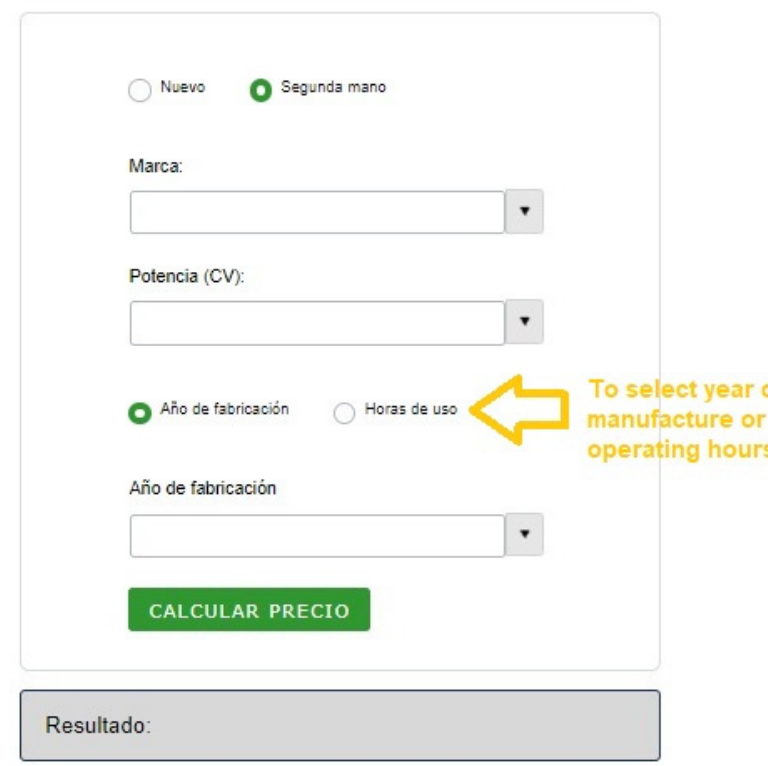
Figure 24. Screenshot of the decision support tool. New tractors.